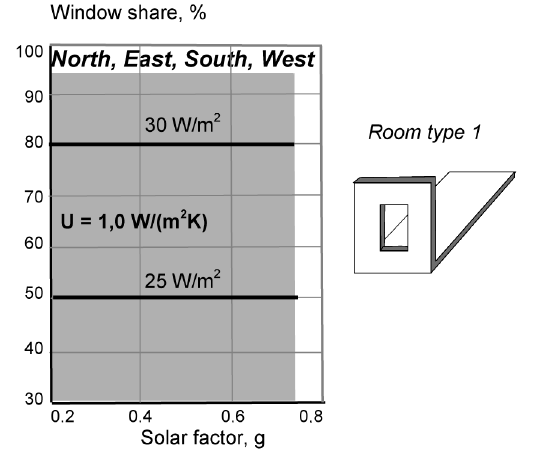
Fig. 14. Possible combinations of window glass share and solar factor for room type 1 for a maximum heating power demand of 2 25 or 30 W/m